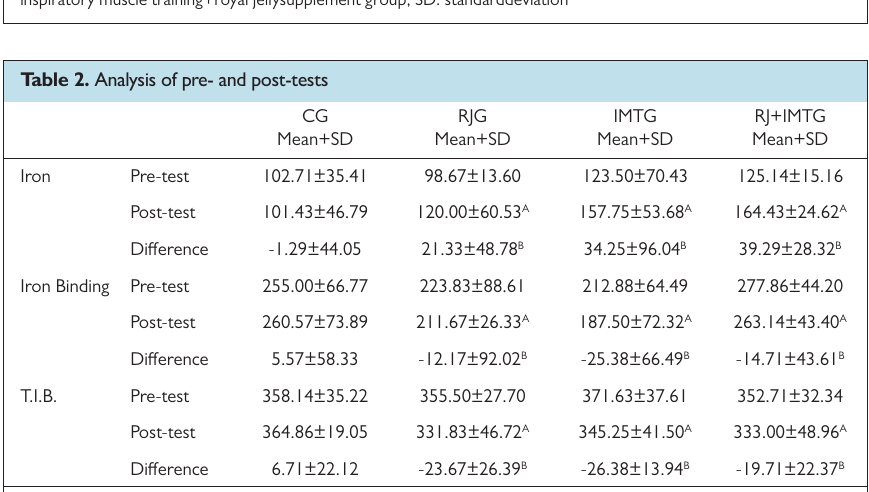
Table 2. Analysis of pre- and